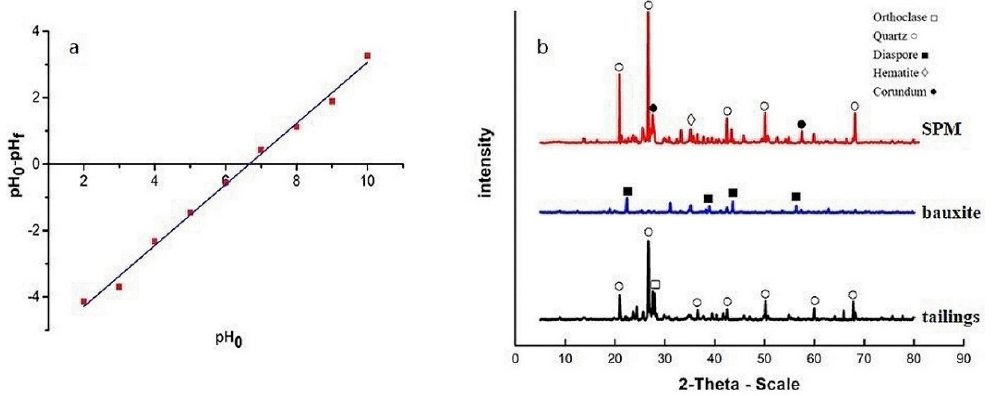
Figure 1. Zero-charge point of the silicate porous material (SPM) (Figure 1 a ) and X-ray diffraction (XRD) patterns of SPM, bauxite, and tailings (Figure 1 b , red for SPM, blue for bauxite, and black for tailings).